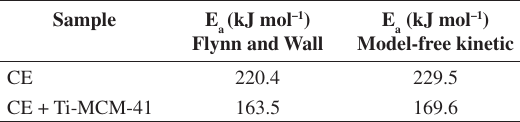
Table 3. Apparent activation energy of biomass